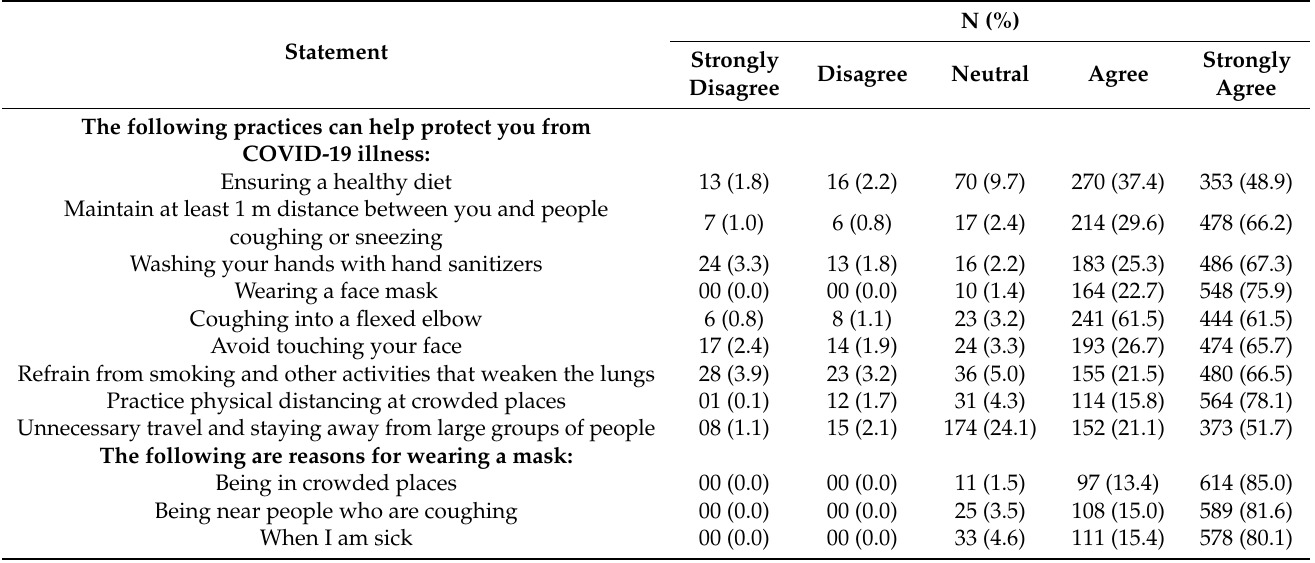
Table 5. Practices related to COVID-19.